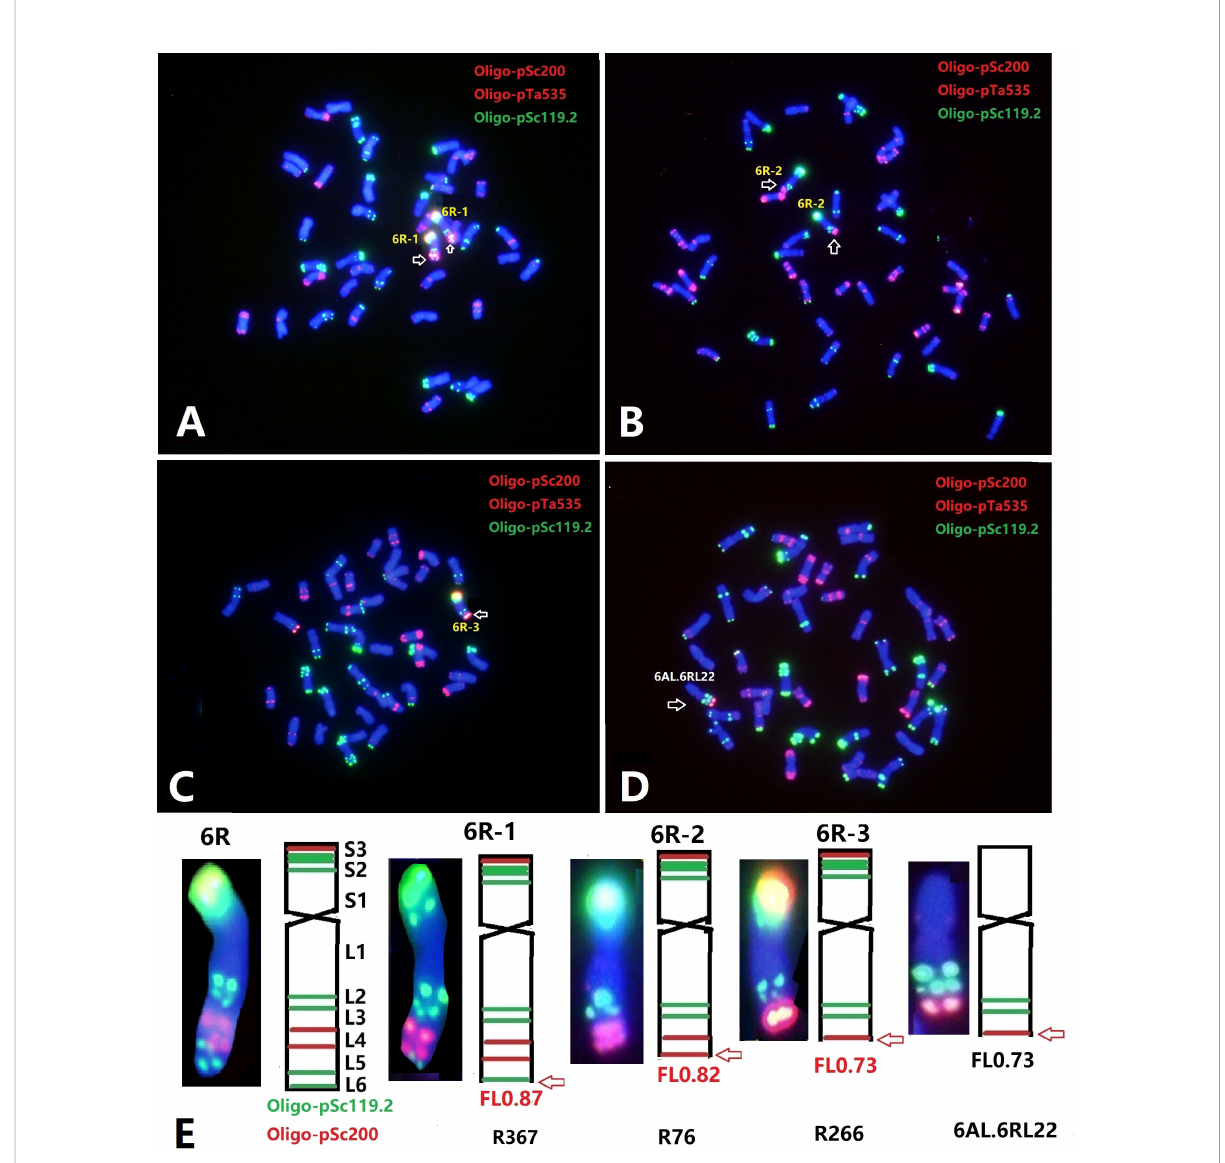
FIGURE 3 ND-FISH of wheat-rye 6R lines from irradiated progenies of Sub6R(6D) lines. The wheat-6R lines contains different types of 6RL deletions (A – D) . The diagrams show the FISH patterns of the 6RL deletions by ND-FISH of Oligo-pSc119.2 (green) + Oligo-pTa535 (red) + Oligo-pSc200 (red) as probes (E)